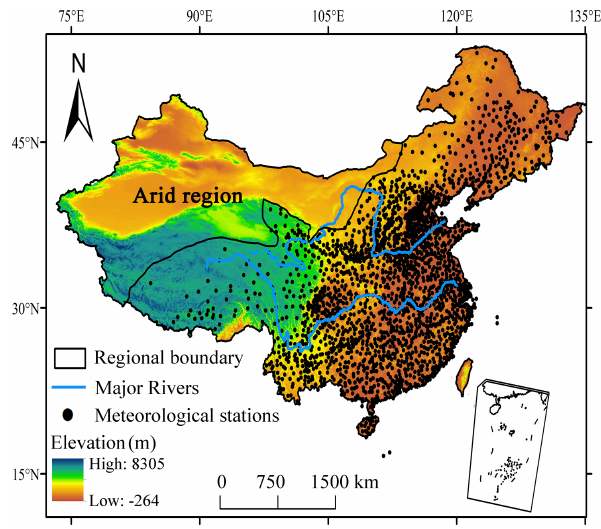
Figure 1. Geographical position of China and meteorological sta-